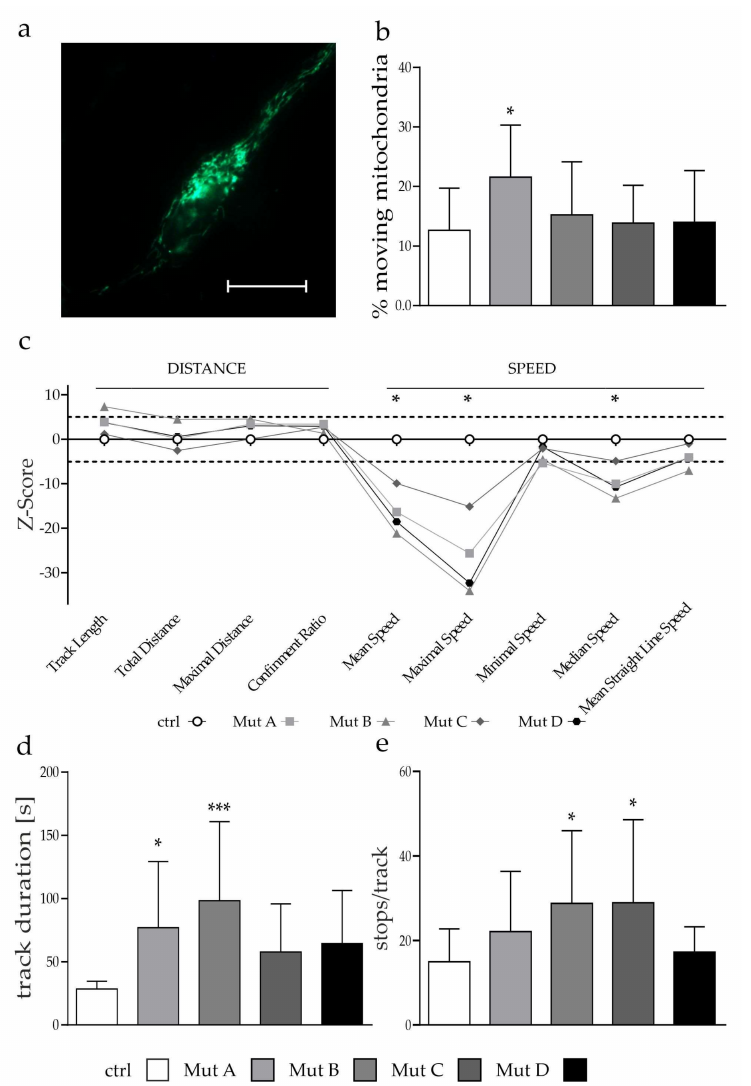
Figure 3. Analysis of mitochondrial transport. ( a ) Example of neural cells transduced with the CellLight TM BacMam 2.0 technology for mitochondria. Scalebar = 20 µ m. ( b ) Analysis revealed that 10–30% of all mitochondria were moving. Mut A showed a significantly increased percentage of moving mitochondria compared to the control cell line. ( c ) Z-score for each of the speed and distance parameters was calculated using the formula in Section 2.3. A Z-score higher than 5 and lower than –5 was defined as significantly different from the control cell line (dashed lines). The symbols of the individual parameters are connected with a line. This was not intended to indicate any relationship between the individual parameters, but only serves to improve the interpretability of the data presented. The traveled distance seemed not to be affected, whereas three speed parameters were reduced. ( d ) Bar graph of the track duration showing a significant increase in Mut A and B. ( e ) Bar graph of the calculated amount of stops/track. All three NPC1-deficient cell lines showed an increased number of stops, but only two were statistically significant. Graphs show mean ± SD with N = 3, n = 30. One-way ANOVA and a Kruskal–Wallis post hoc test were used to determine statistical significance, with * = p < 0.05, *** = p < 0.001. ctrl = control cell line. Mut A (NP-C1): c.1180T>C; Mut B (NP-C1): c.1836A>C/c.1628delC; Mut C (NP-C1): c.3182T>C; Mut D (NP-C2):